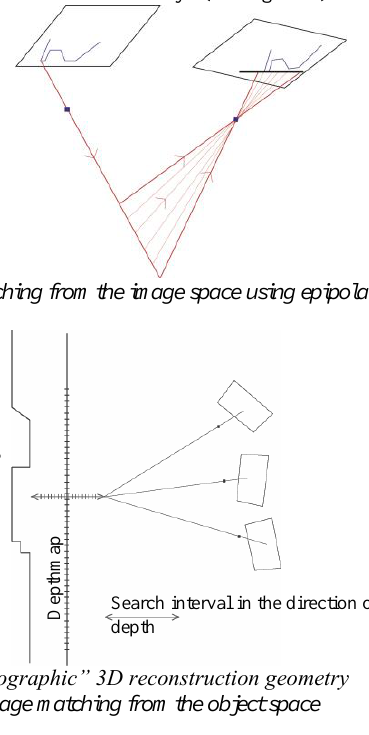
Figure 7: Two 3D reconstruction geometries [Héno et al. ,